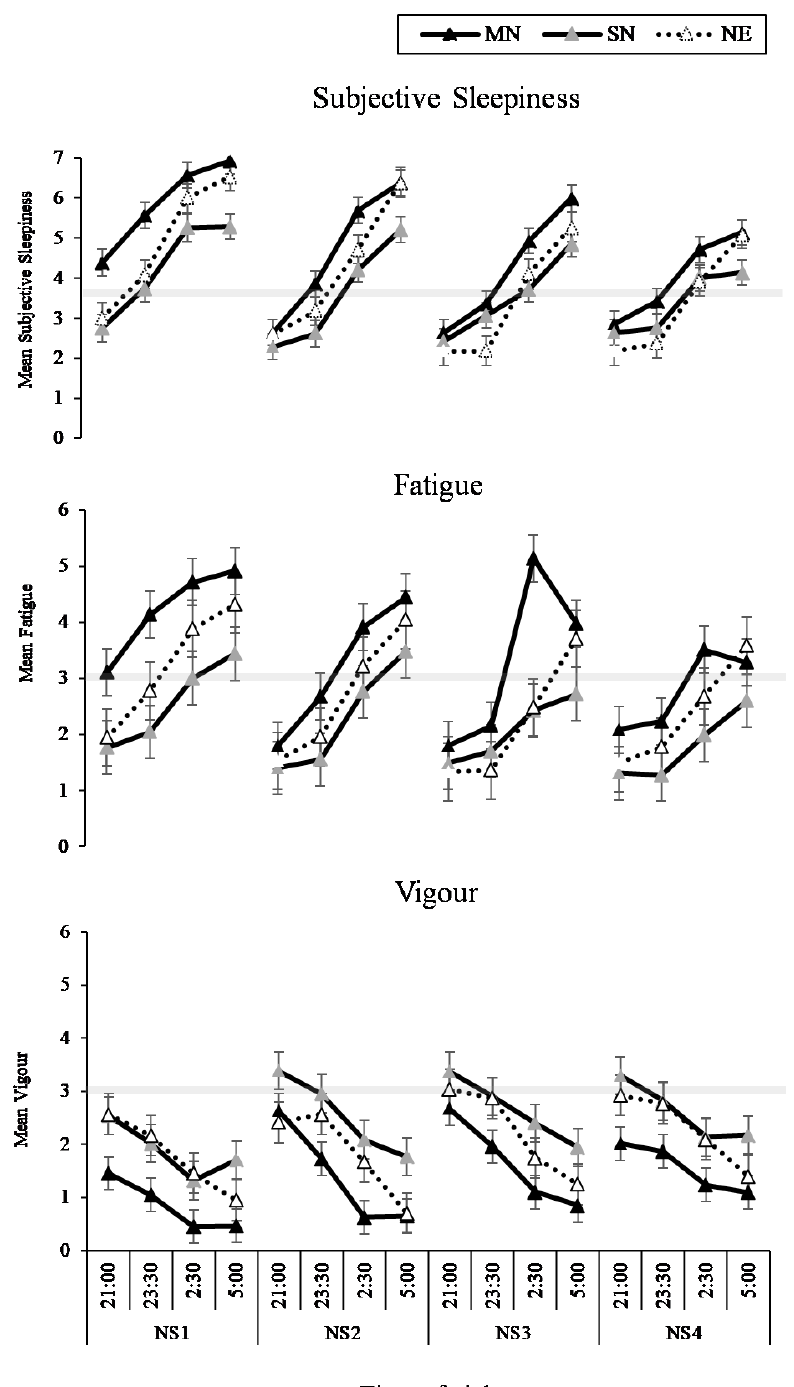
Night condition NE). The vertical black line on each line graph indicates when the meal or snack was consumed. The grey shaded horizontal line on each line graph indicates the midpoint of each VAS. Means presented are estimated marginal means, and error bars indicate standard errors from model estimates. Asterisks indicate a significant interaction effect (* p < 0.05).